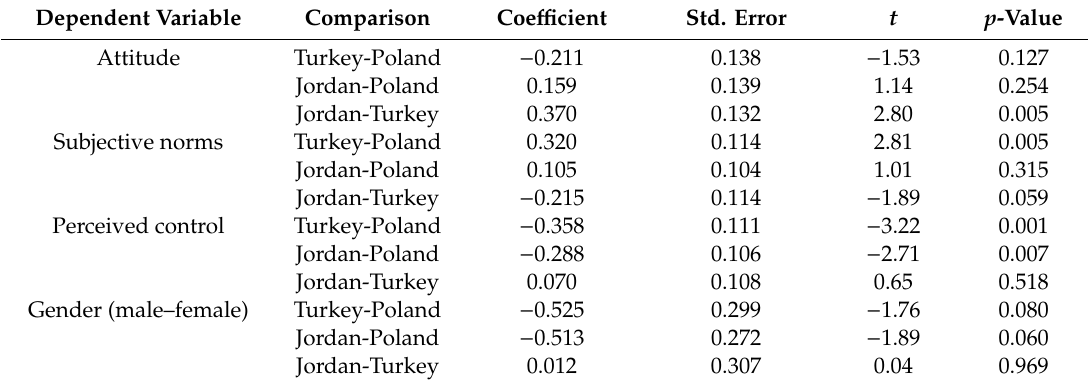
Table 4. Comparisons of coe ffi cients in multiple regression (dependent variable: behavioural